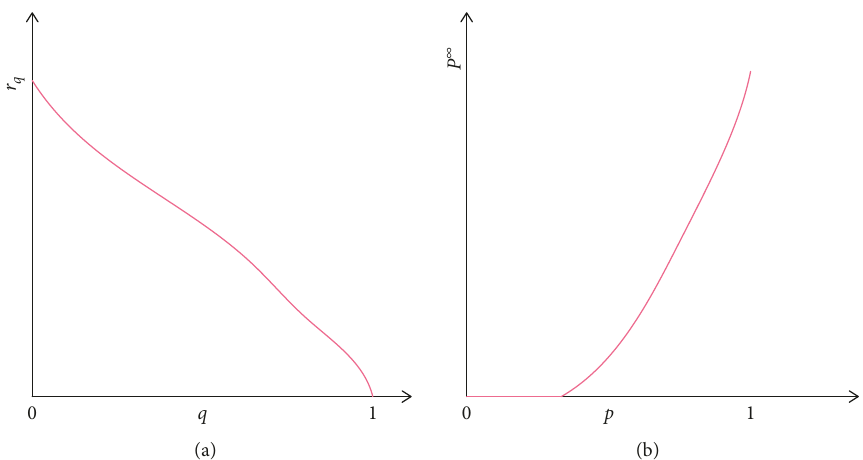
Figure 2: Ideas of two widely adopted methods for network robustness analysis. (a) Idea of the method based on the calculation of r fraction of nonzero degree nodes after removing q fraction of the nodes from a network [56, 60, 65]. (b) Idea of the method based on the calculation of P ∞ , i.e., the fraction of nodes in the largest connected component of a network after removing 1 − p fraction of its nodes [16, 21,